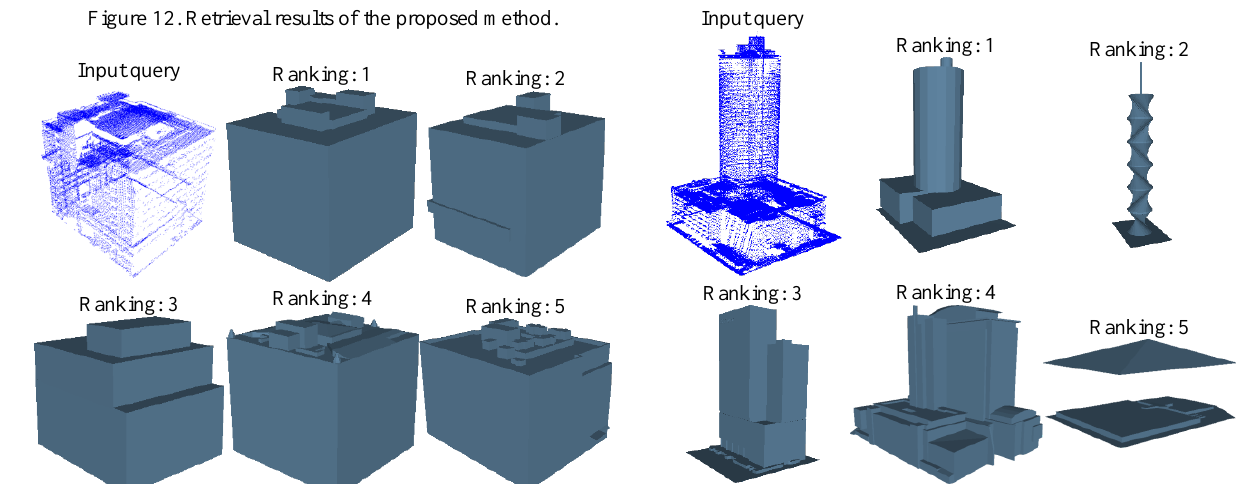
Figure 16. Retrieval results of the proposed